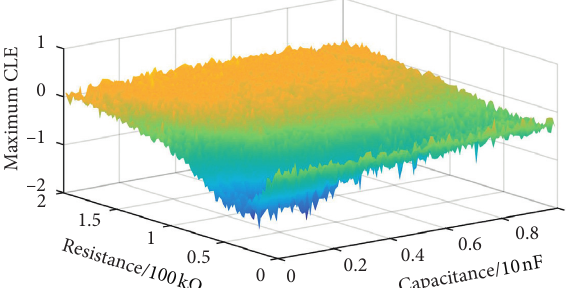
Figure 8: Maximum CLEs of error system (10) with resistive and capacitive coupling by parallel